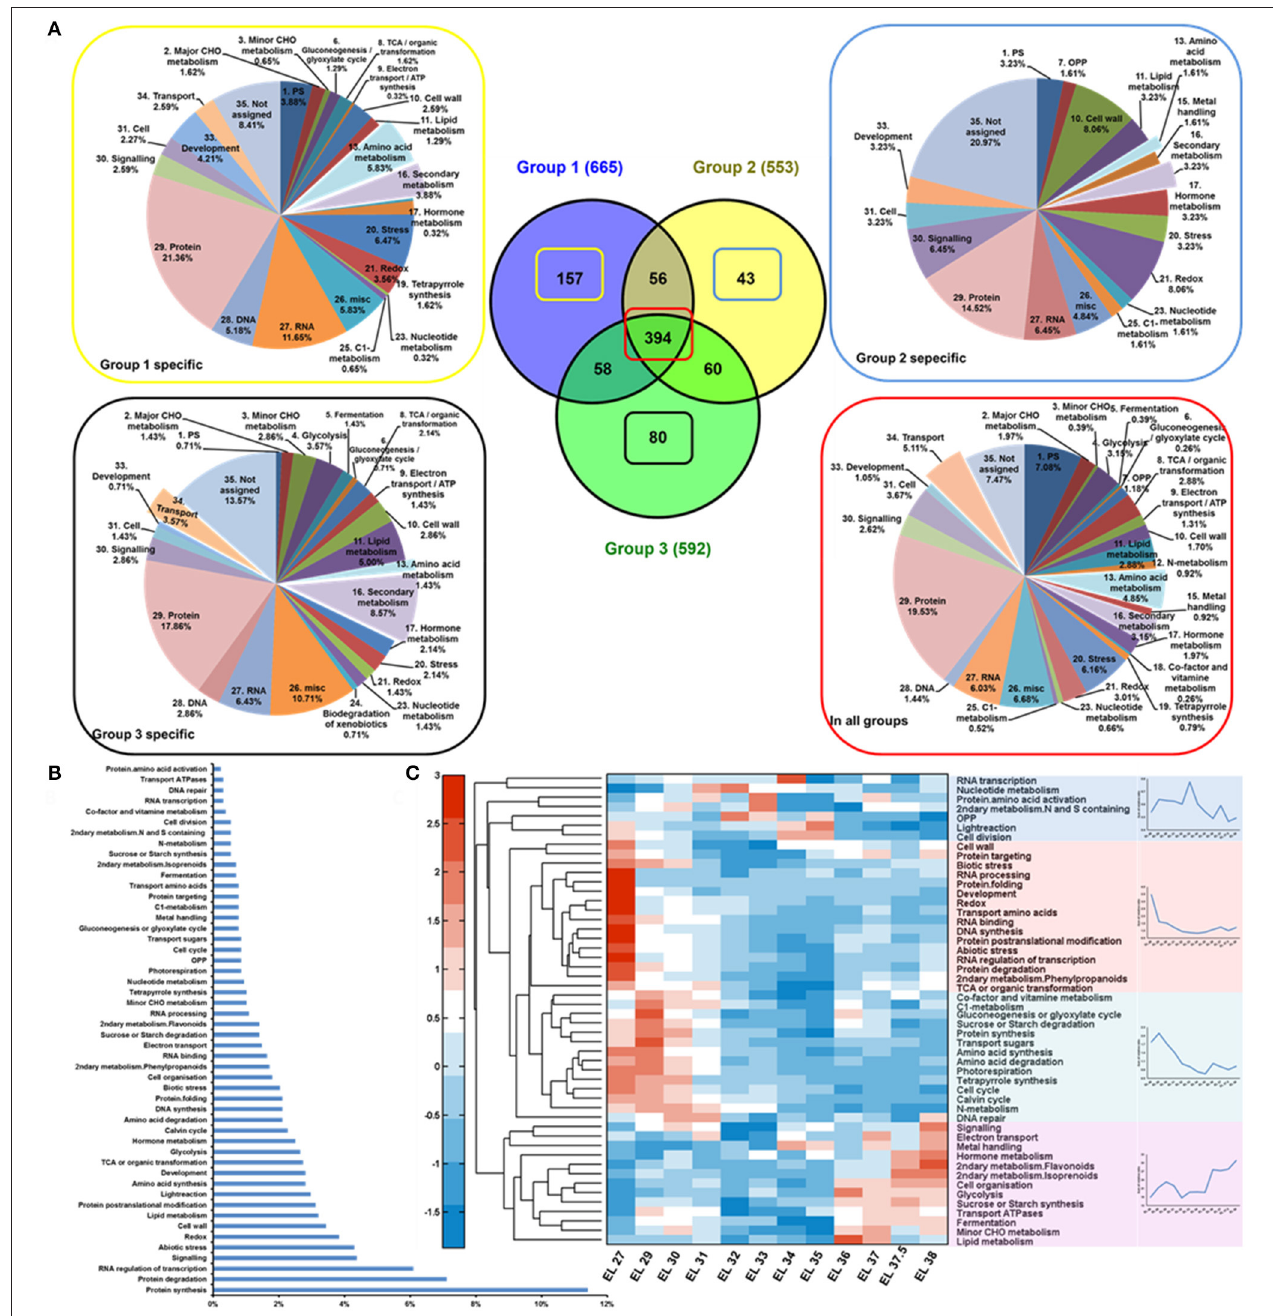
FIGURE 3 | Proteomic analysis of developing grape berries. (A) Protein distribution throughout the developmental process. Samples of 12 developing stages were sorted to 3 groups with group 1 including samples at stage EL 27, 29, 30, 31; group 2, EL32, 33, 34, 35 and group 3, EL 36, 37, 37.5, 38. The proteins that specific to group 1, 2, 3 and those common to all groups were functionally summarized with pie charts in yellow, blue, black and red box respectively. (B) Protein frequencies. (C) Protein dynamics. Four distinctive changing patterns were summarized with line charts.